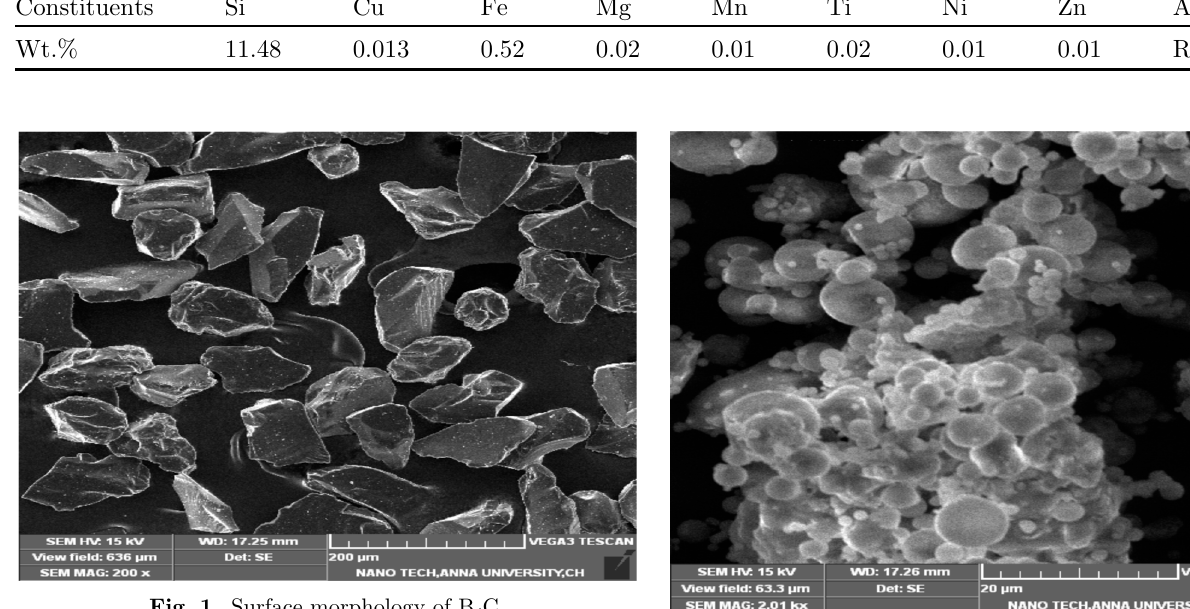
Fig. 2. Surface morphology of fl y ash.